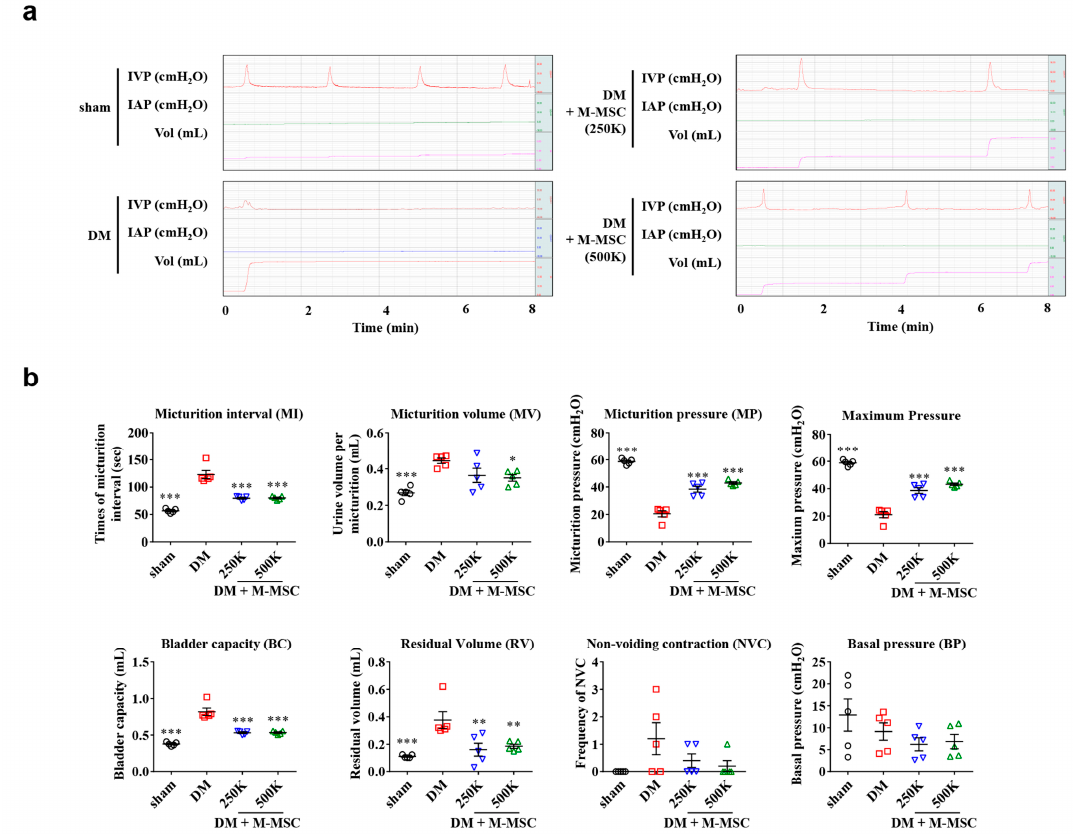
Figure 3. Dose-dependent effects of M-MSCs on bladder function. ( a ) Representative awake cystometry results and ( b ) quantitative voiding data 1 week after injection of 2.5 × 10 5 (250 K) or 5.0 × 10 5 (500 K) M-MSCs into the bladders of DM rats. Data are presented as mean ± SEM ( n = 5, * p < 0.05, ** p < 0.01, and *** p < 0.001 relative to DM group, one-way ANOVA with Bonferroni post-hoc test comparison). The exact experimental and statistical values can be found in the Supplementary Table. DM: diabetes mellitus; M-MSC: Multipotent-mesenchymal stem cell.